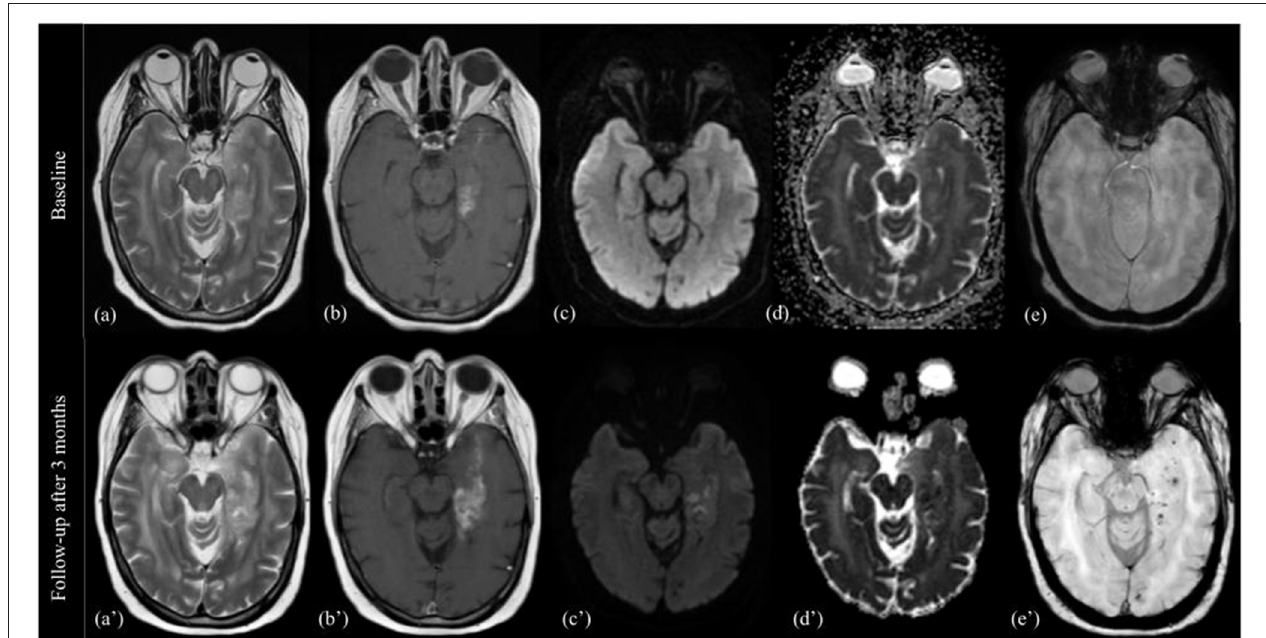
FIGURE 1 | Pattern A. MRI changes in recurrent high grade glioma under regorafenib, pattern A. MRI scans performed at baseline (top image) and 3 months after first administration of REG therapy (bottom image). T2-weighted images (a,a’) , T1-weighted images with gadolinium (b,b’) , DWI images (c,c’) , apparent diffusion coefficient (d,d’) , and SWI images (e,e’) are shown from left to right. The 3-month follow-up showed increase in size, more than 25%, of enhancing tumor in the left temporo-mesial area, and progressive extension into the ipsilateral parahippocampal gyrus. T2 signal intensity was similar to the previous MR exam, but contained focal hyperintensities on DWI (corresponding to low ADC values), and multiple black dots on SWI.